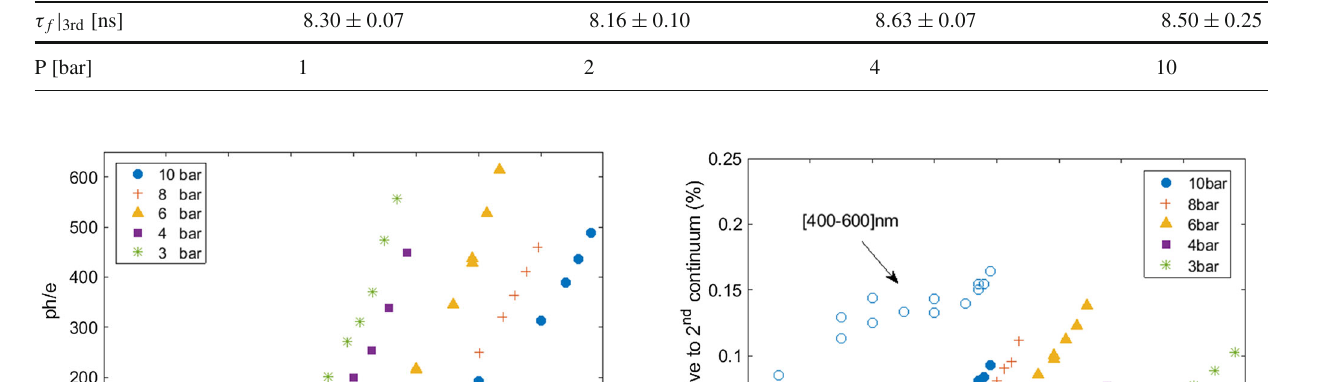
Table 2 Time constants obtained in this work for the 3rd continuum band at different pressures (largely independent from the pressure- reduced field in the range 0–100 V/cm/bar). The value for the fast com- ponent of the 2nd continuum (singlet), obtained from a fit to the unfil-